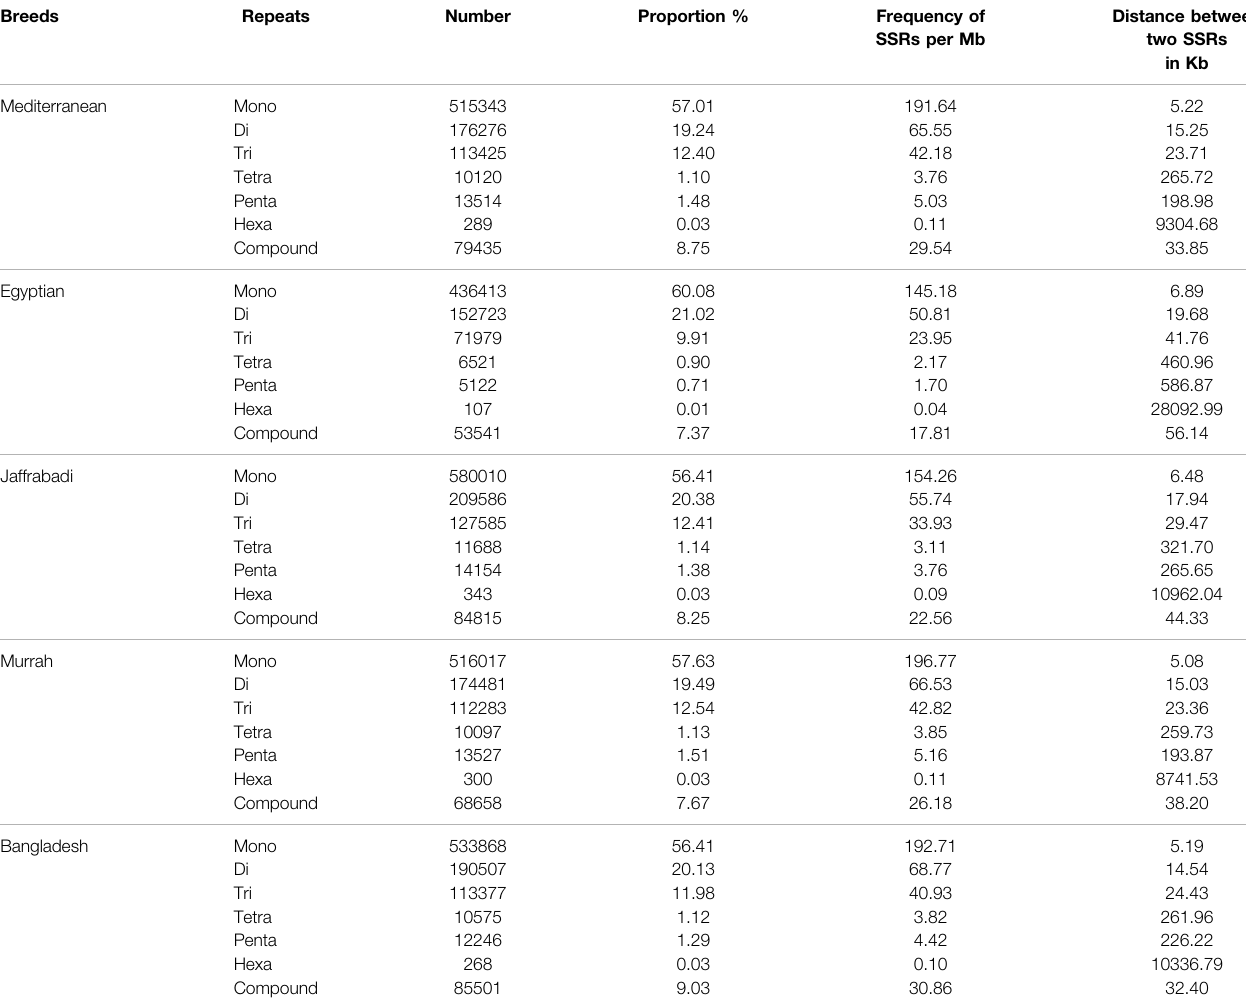
TABLE 5 | Breed-wise frequencies of SSRs, their proportions, SSR density, and distance between two SSRs in different repeat motifs. Breeds Repeats Number Proportion % Frequency of